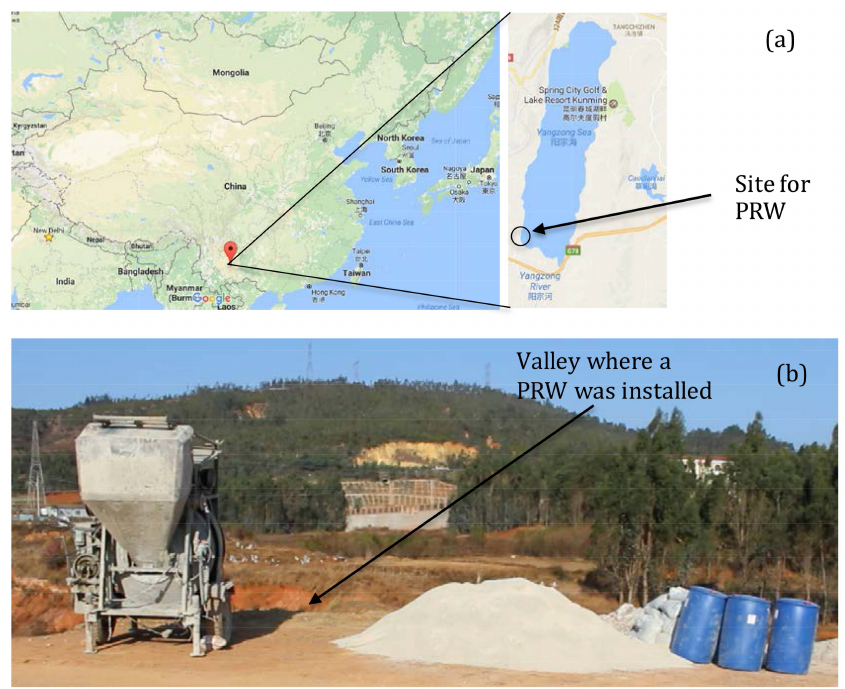
Figure 2. The location of the pilot test site ( a ); The ILMZ was produced on site with a concrete mixer ( b ). The zeolite is in foreground and the IL is in the blue drums. The bags behind the drums are unopened zeolite bags about 100 kg each. The valley where the PRW was installed is in the middle of the picture behind the mixer.